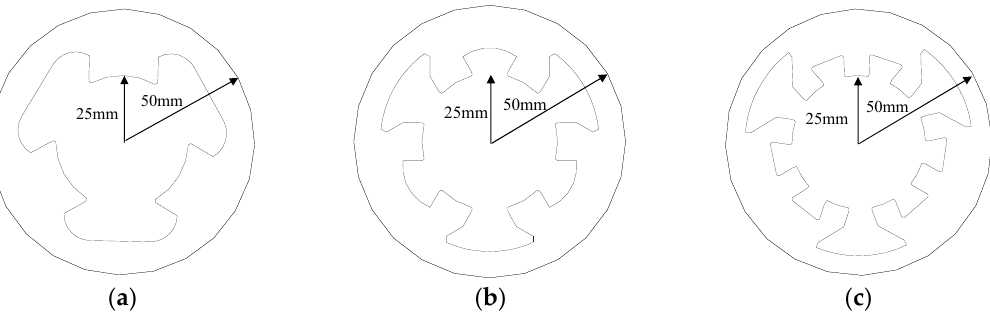
Figure 5. Stators with different auxiliary poles n aux for FE simulations. ( a ) n aux = 1; ( b ) n aux = 2; ( c ) n aux = 3.